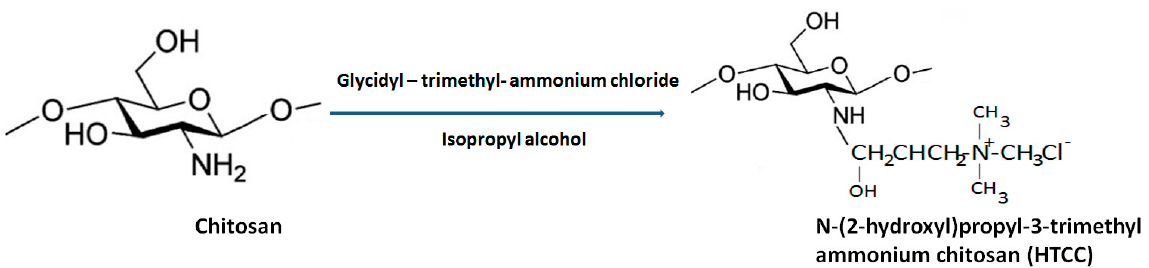
Figure 6. General synthesis of HTCC from biopolymer chitosan.